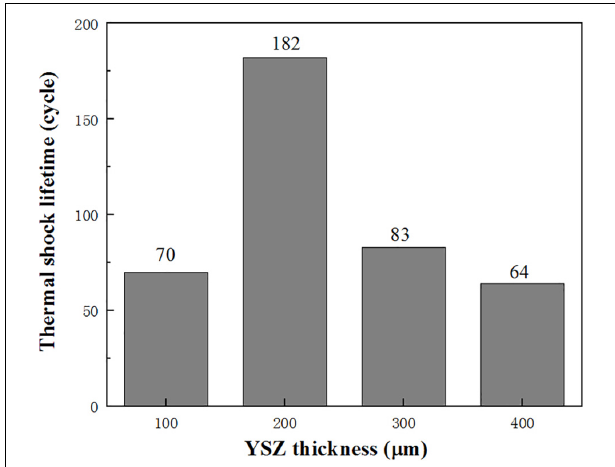
FIGURE 6 | Thermal shock lifetime of TBCs system with different YSZ coating thicknesses at 230 ◦ C.